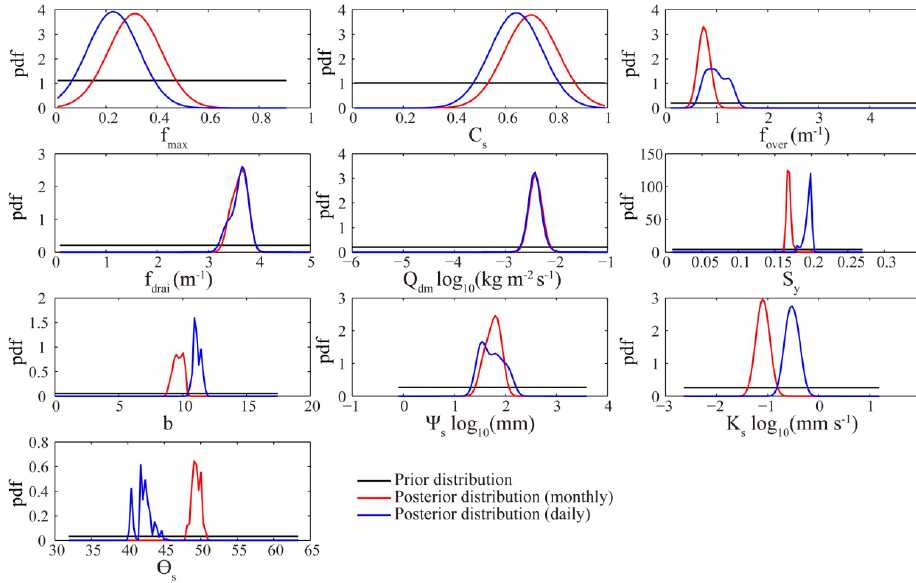
Figure 14. Posterior distribution of the parameters through Bayesian model averaging at the MOPEX basin. 835